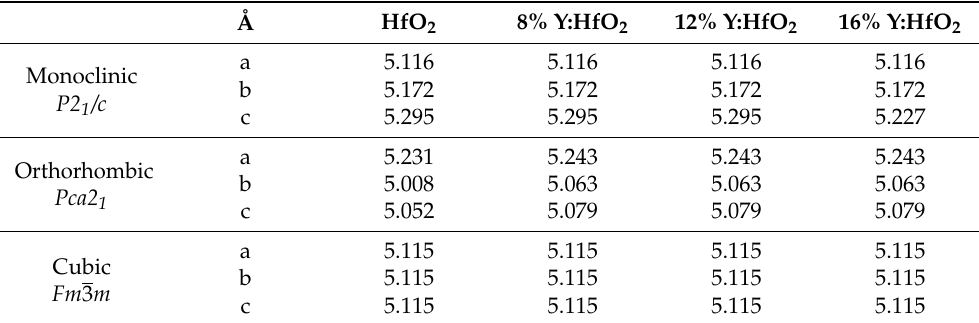
Table 1. Lattice vectors for monoclinic P2 1 /c, orthorhombic Pca2 1 , and cubic Fm 3̅ m polymorphs of HfO 2 , 8% Y:HfO 2 , 12% Y:HfO 2 , and 16% Y:HfO 2